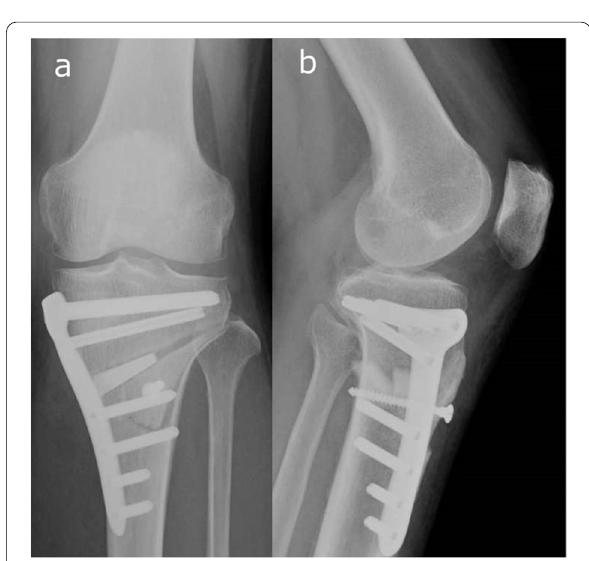
Fig. 2 Radiographs after medial open-wedge DTO. A Anteroposterior radiograph. B Lateral